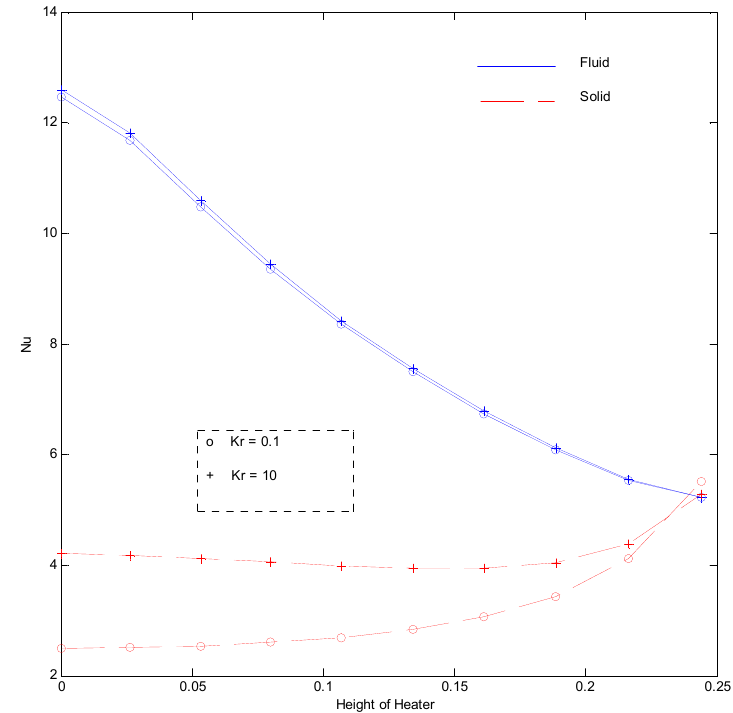
= x . Figure 16. Nusselt number at Ra